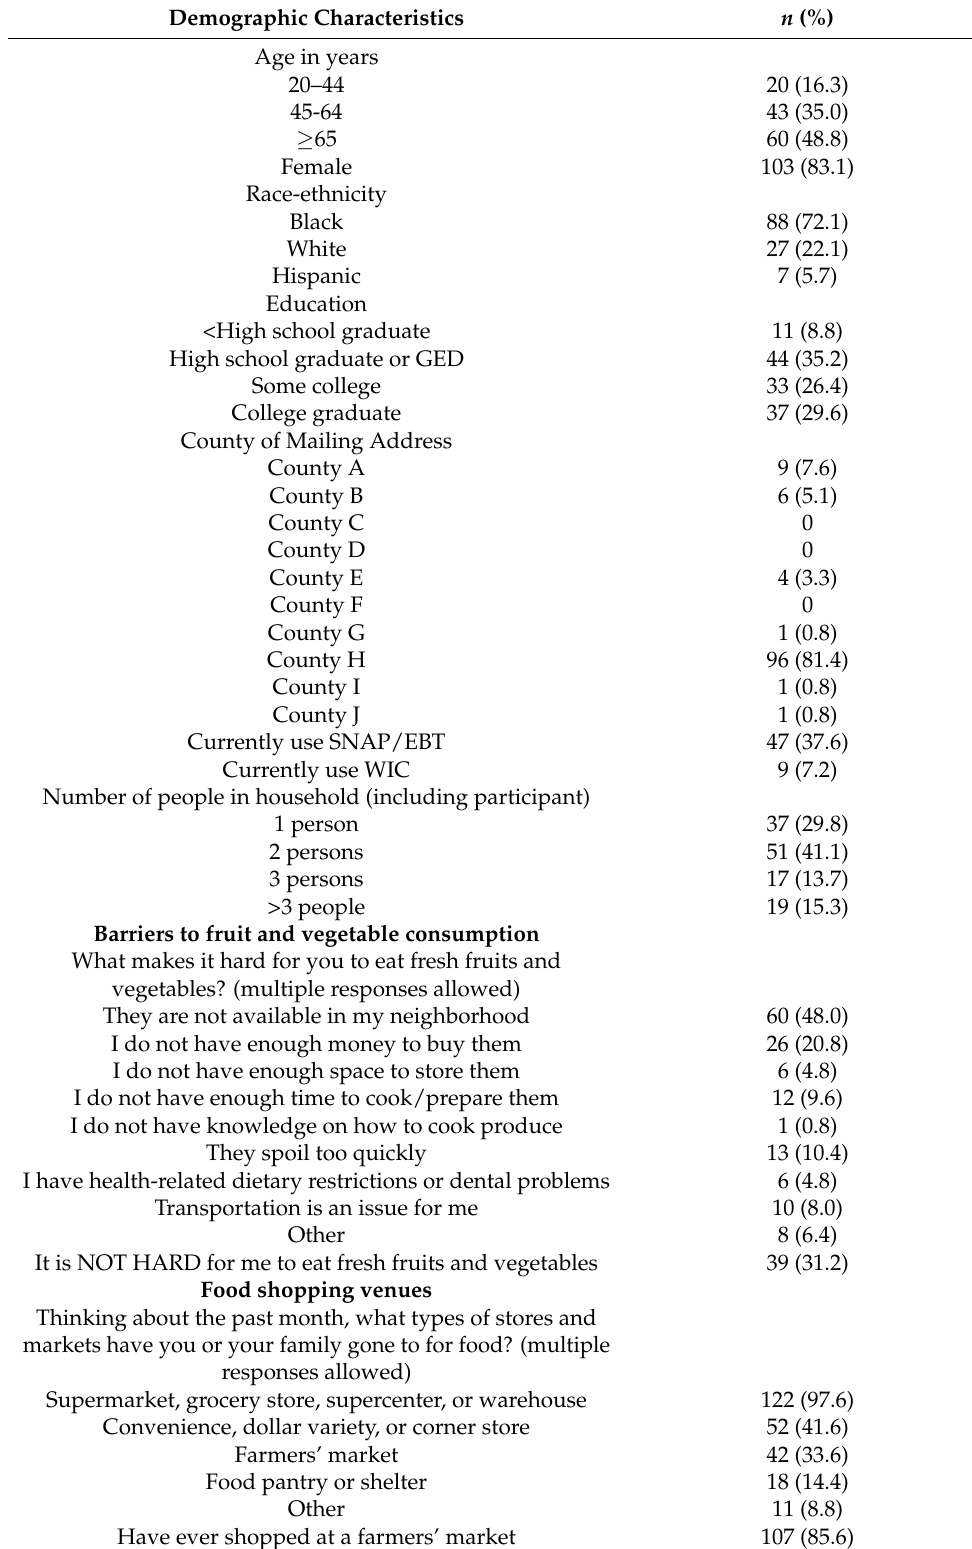
Table 2. Demographic and food-related characteristics of the participant sample, 2021 produce prescription program, n =